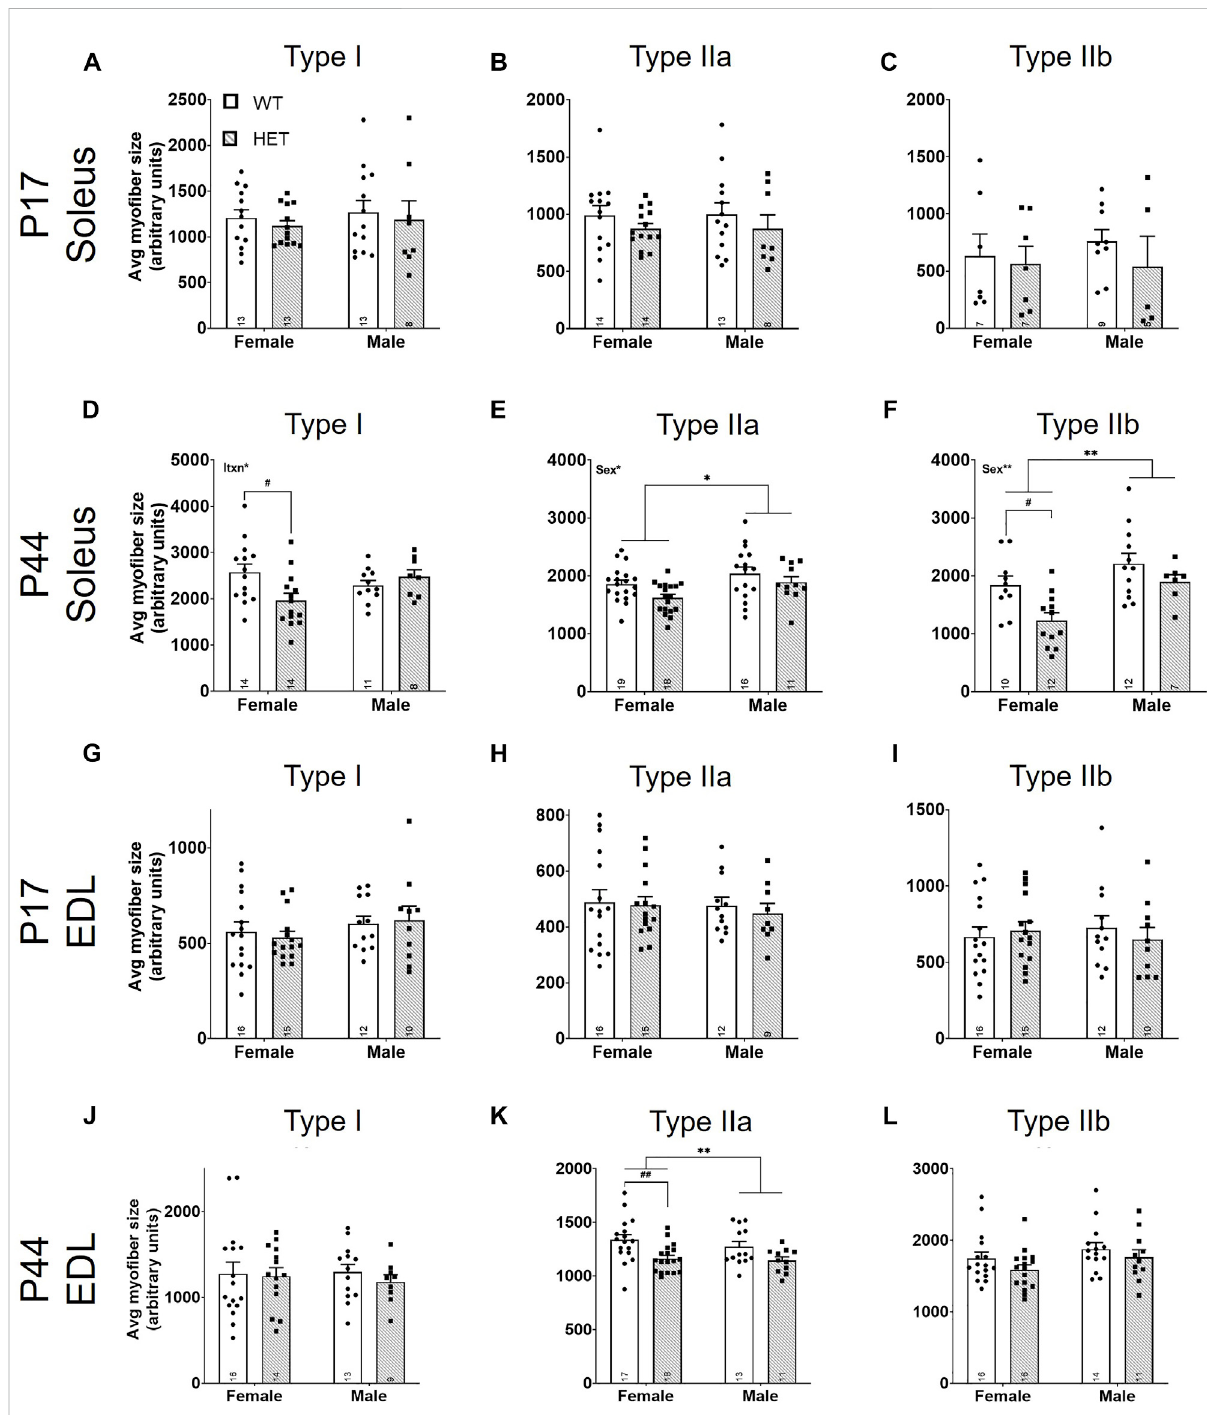
Average fast-twitch myo fi ber size is decreased at P44. For myo fi ber types (I, IIa, and IIb), average size was scored using the total myo fi ber type areabyimmuno fl uorescence/myo fi bertypecount (Figure4;y-axes).Graphs show resultsof eachmyo fi ber typeinmales andfemalesfromP17SOL (A – C) , P44 SOL (D – F) , P17 EDL (G – I) , and P44 EDL (J – L) . WT : dots and open bars; HET : squares and grey hatched bars. * p < 0.05; ** p < 0.01 (2-way ANOVA). # p < 0.05; ## p < 0.01 (post hoc test; effect of genotype only). Effects of sex or an interaction (itxn) between sex and genotype by